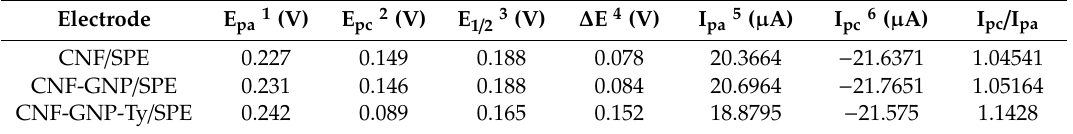
Table2. ElectrochemicalparametersobtainedfromvoltammogramsofsensorsimmersedinK 4 [Fe(CN) 6